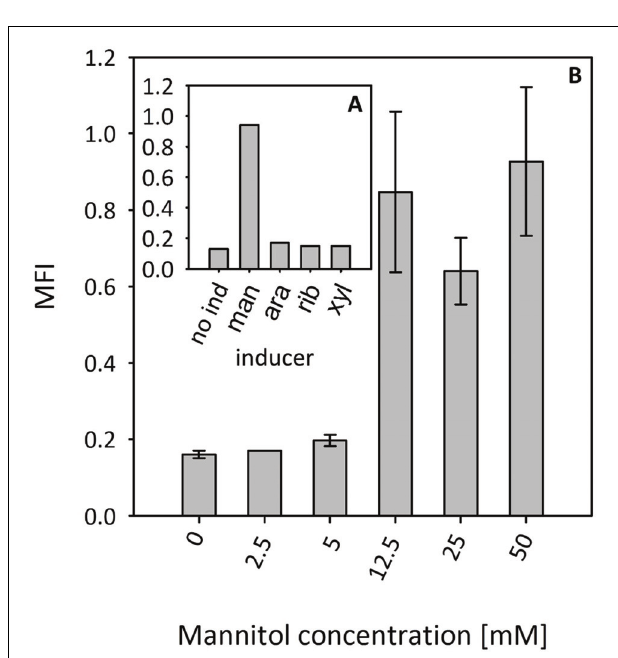
FIGURE 5 | Specificity and dynamic range of induction of the B. methanolicus mtlR promoter. (A) Screening of sugar alcohols as potential inducers. Single replicates of shake flask cultures are presented. (B) Expression titration with different mannitol concentrations. Abbreviations: no ind, no inducers; man, mannitol; ara, arabitol; rib, ribitol; xyl, xylitol; MFI, median fluorescence intensity of GFPuv given in a.u. GFPuv fluorescence of exponentially growing cells was measured after 2 h incubation at 37 ◦ C and 200 rpm Mean values and standard deviations of triplicate shake flask cultures are presented.